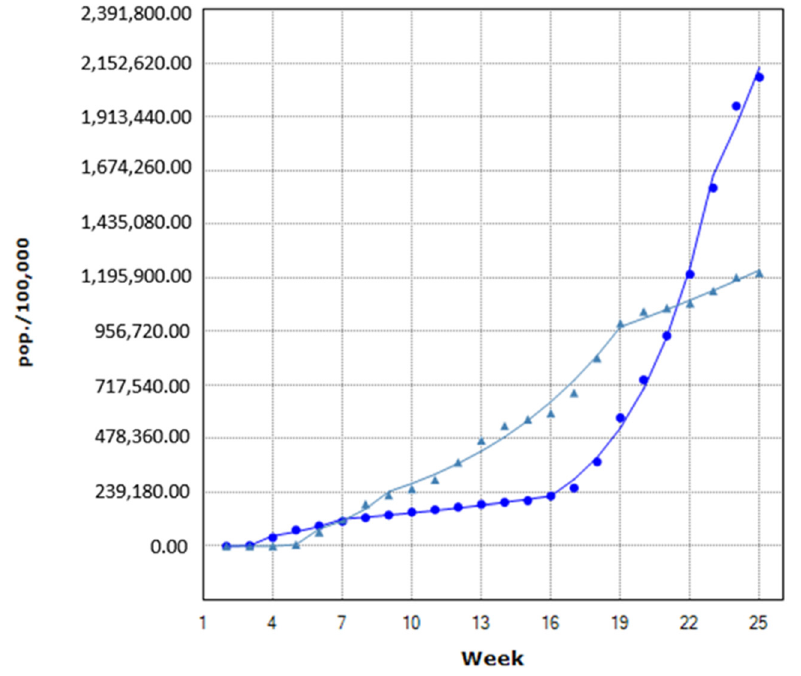
Figure 2. Average weekly vaccination trends by age in subjects <70 years (blue dots) and those >70 years (blue triangles).